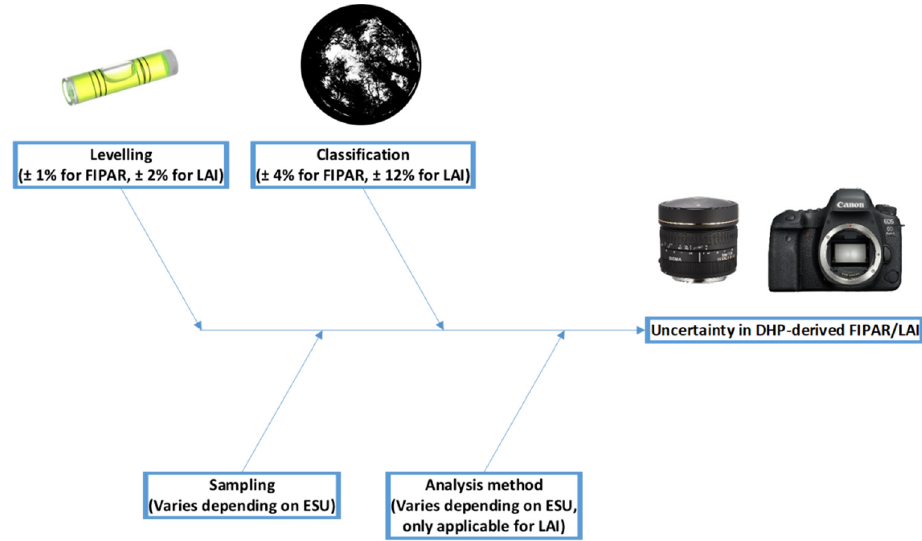
Figure 4. Uncertainty tree diagram illustrating the components contributing to uncertainty in DHP-derived FIPAR and LAI values.